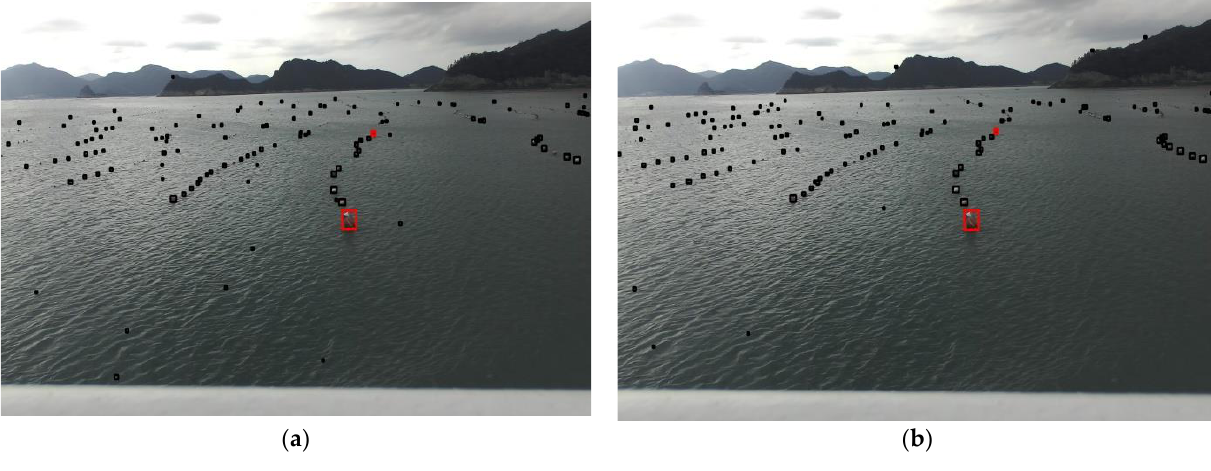
Figure 20. Key point matching by ORB (Experiment B). Figure 21. Feature-based stereo matching results (Experiment B).